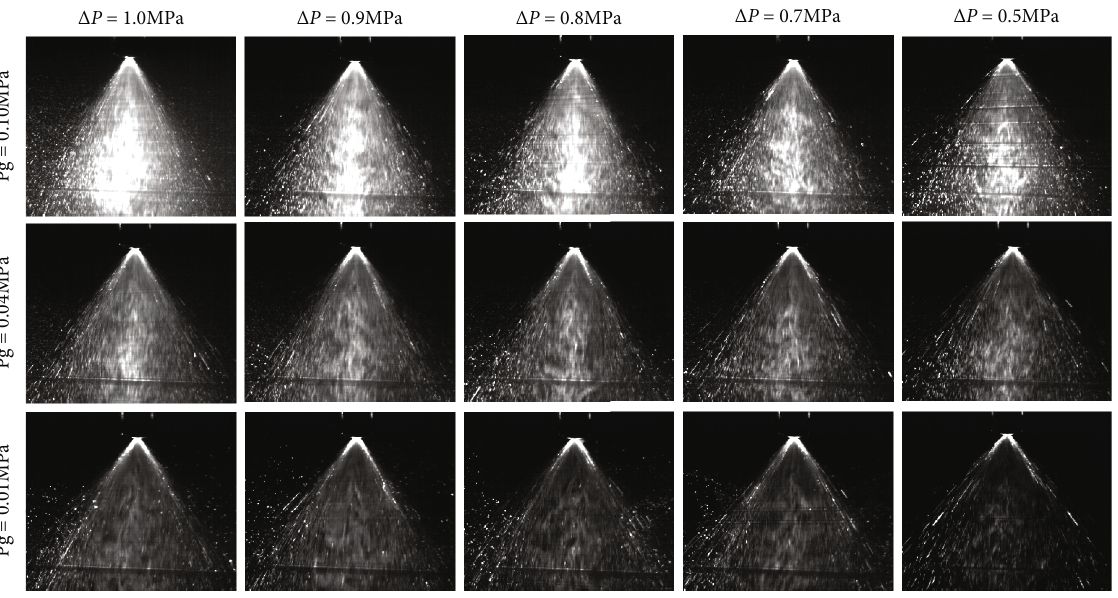
Figure 4: Spray images of 1 #